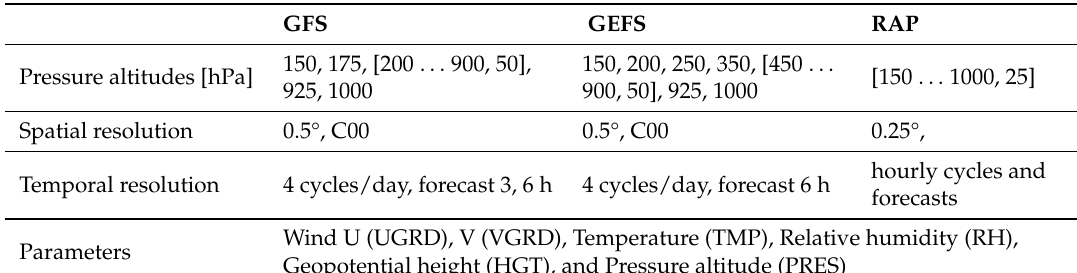
Table 2. Weather input